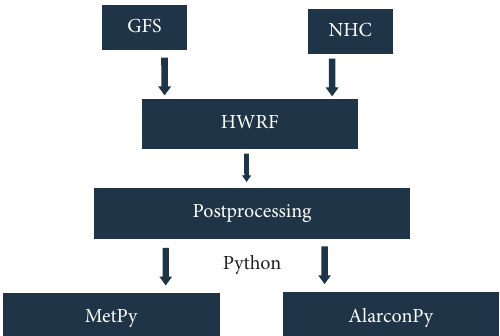
Figure 1: NTHF block diagram. MetPy and AlarconPy are Python packages for the treatment and management of meteorological